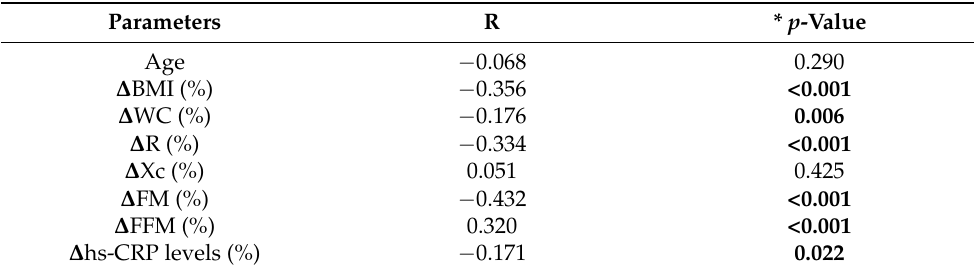
Table 4. Correlation among ∆ %HGS with age, ∆ %anthropometric parameters, ∆ % body composition parameters, and ∆ % of hs-CRP